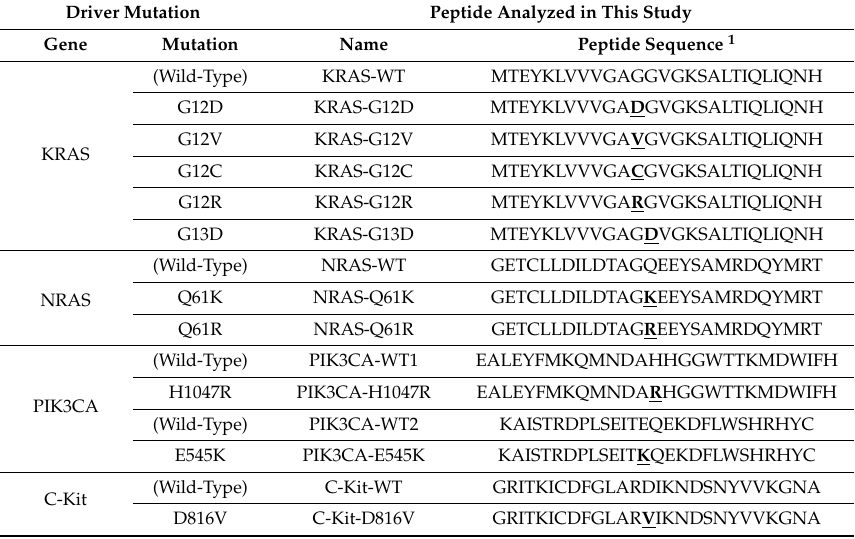
Table 1. List of the synthetic peptides derived from driver mutations. Driver Mutation Peptide Analyzed in This